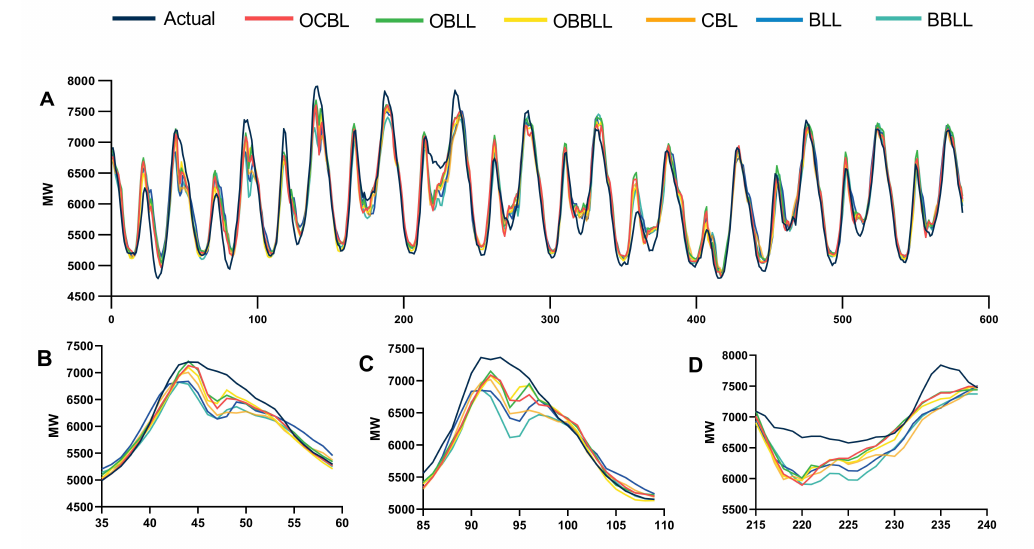
Figure 13. The prediction results and local observation for 5-step forecasting in 2019. ( A ) represents the whole prediction result. ( B – D ) describe the prediction result of different local observation